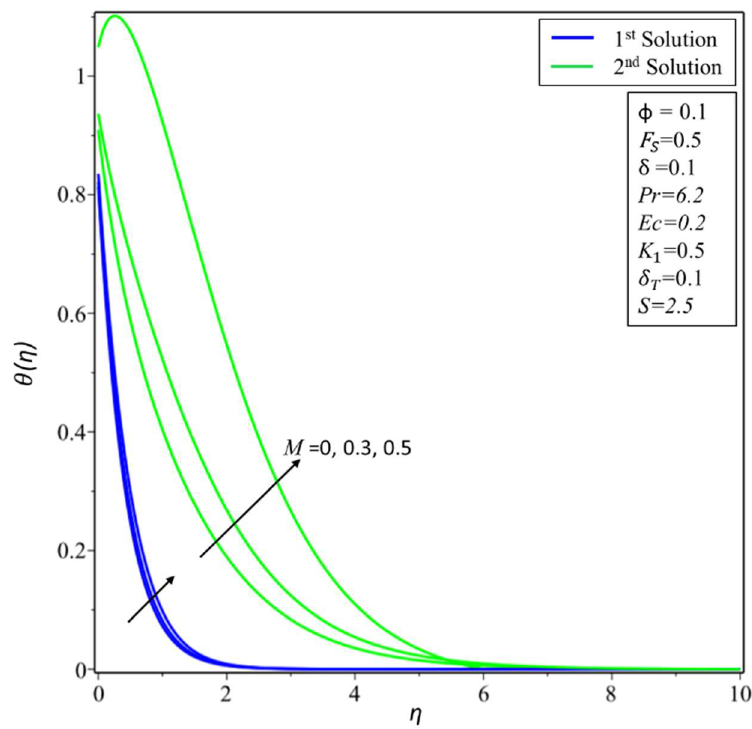
Figure 5. Changes of 𝜃(𝜂) for 𝑀 .